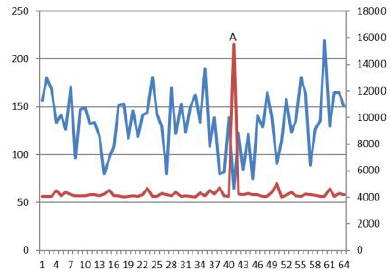
Figure 14: Details ofTexture Mapping Result.